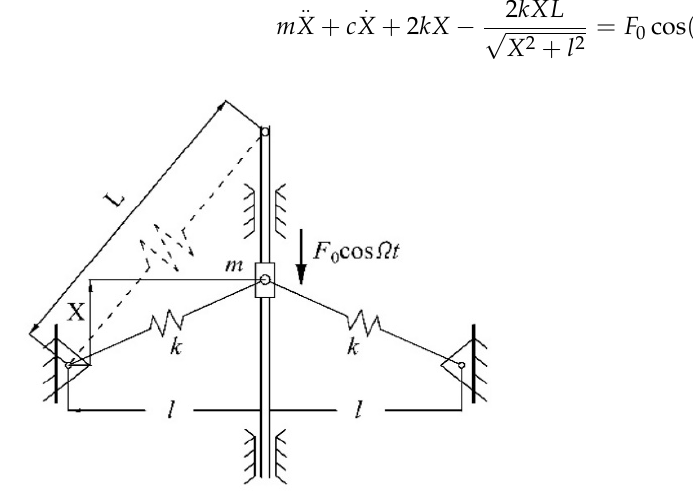
Figure 1. Schematic diagram of the harmonically excited SD oscillator. . When